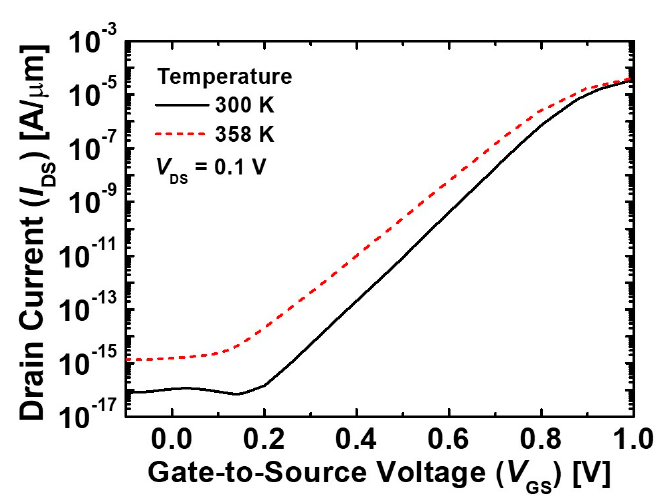
Figure 2. Transfer curves of the GAA-JLFET-based 1T-DRAM at temperatures of 300 K and 358 K.